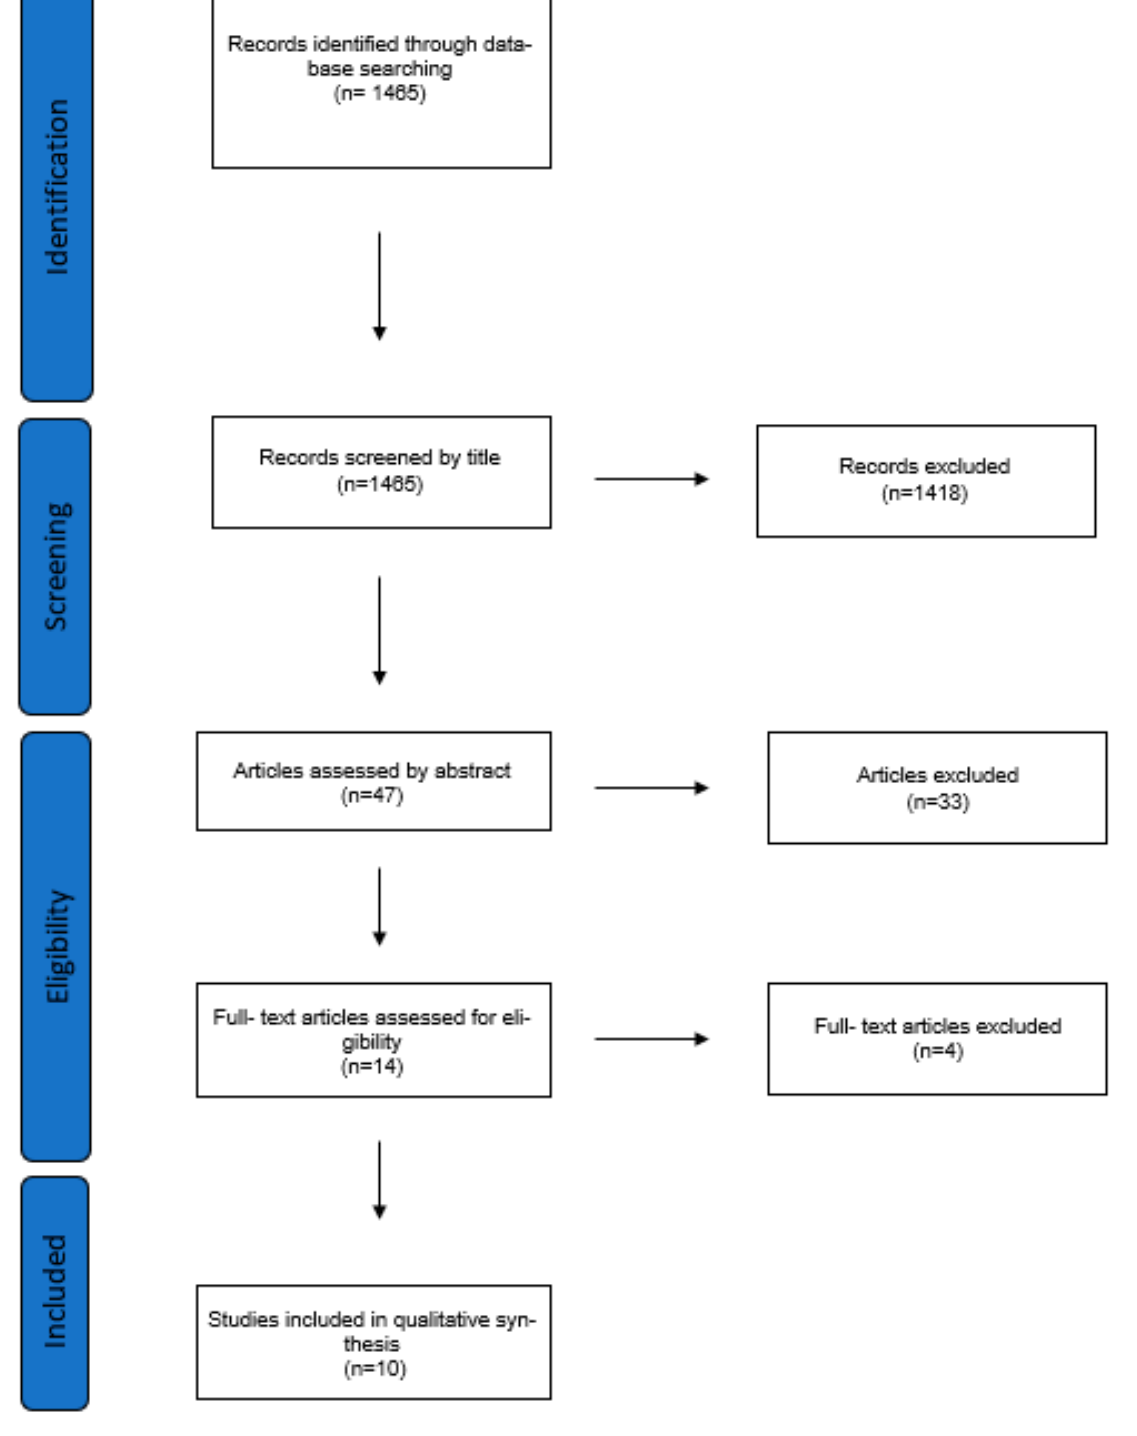
Figure 1. Flowchart of article selection.